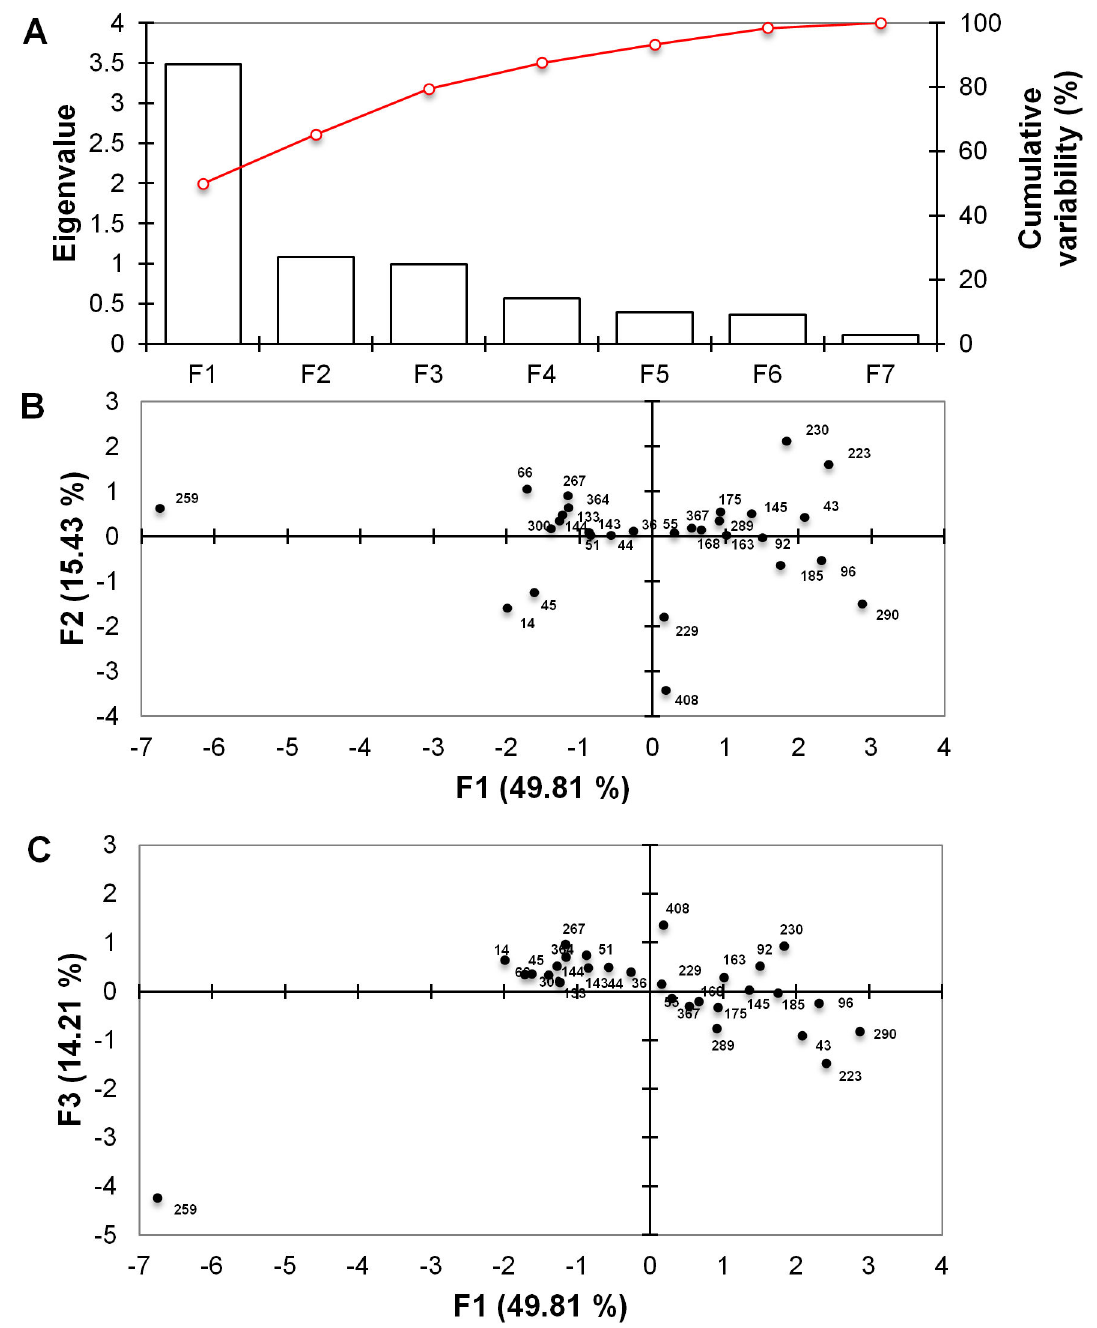
Figure 3. Principal component analysis (PCA) of tertiary screen. Principal component analysis (PCA) was used to reduce the dimension of the tertiary dataset comprising of several interrelated variables (no alcohol, ethanol and butanol treatments on all 29 transformants) whilst retaining the variation present within the dataset. The dataset was transformed into variables (F1-F7) through component analysis using XLSTAT (Addinsoft) v2013.1 software. Scree plot of PCA analysis with the first three Eigenvalues (F1- F3) corresponding to the highest percentage of variance ( A ) Observation plot (built on Scree plot) in the factor space according to the first and second Principal components F1 and F2 ( B ) Observation plot (built on Scree plot) in the factor space according to the first and second Principal components F1 and F3